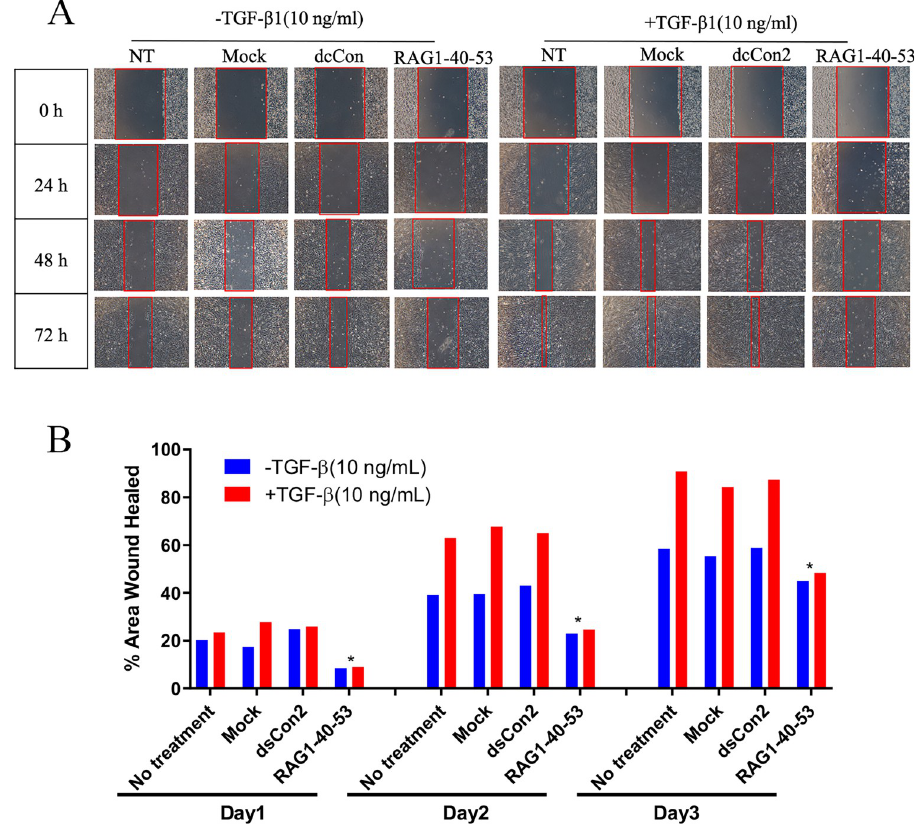
Fig 3. Effects of RAG1-40-53-C1 on ARPE-19 cell migration. (A) Scratch test, wound healing of ARPE-19 cells on 0h, 24h, 48h, 72h; (B) The area wound healed of the transfected saRNA group was significantly different from that of the three control groups.( � P <